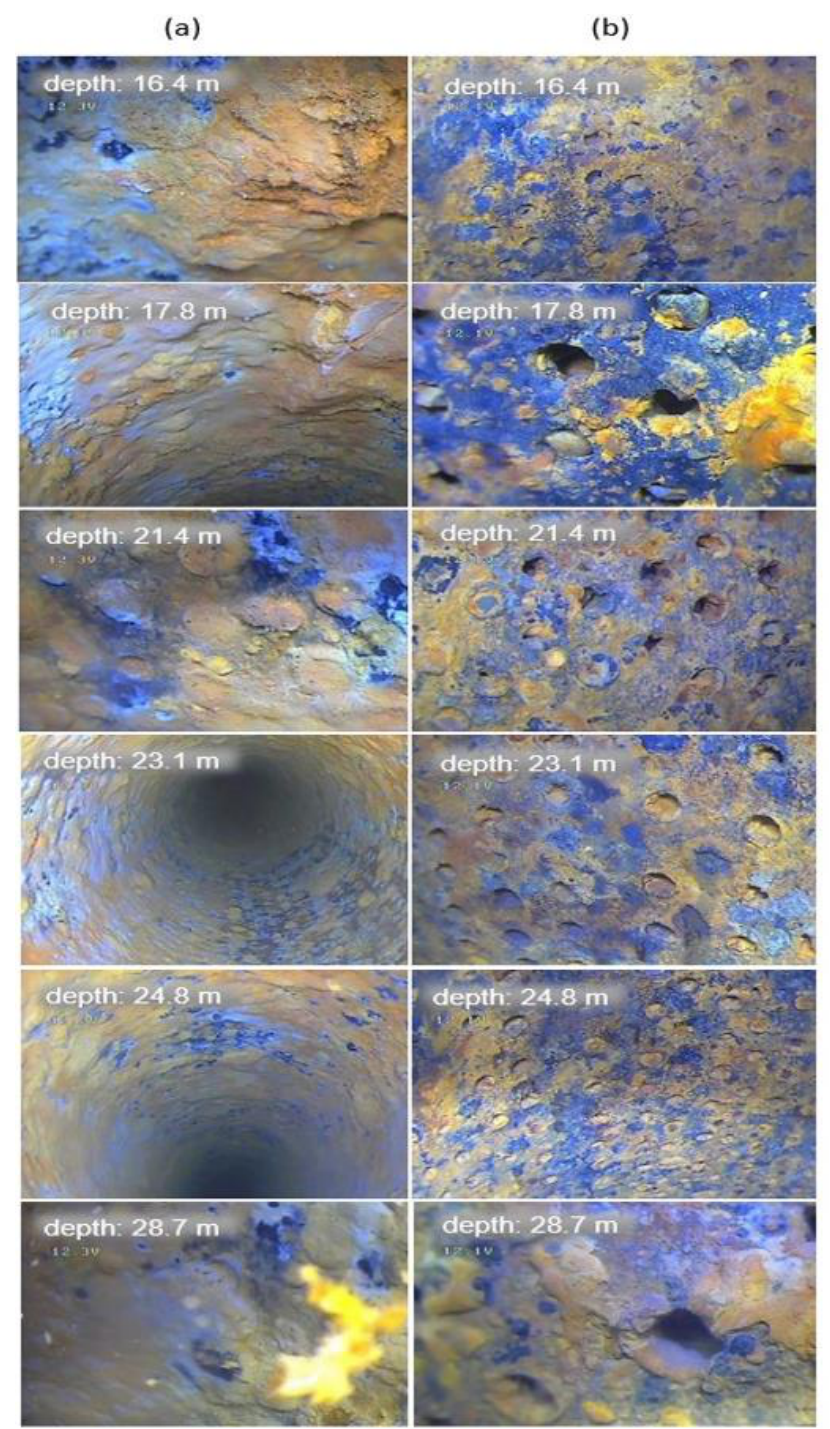
Figure 8. Example of a camera inspection of the interior of well MO-4 at different depths before ( a ) and after ( b ) rehabilitation. and after ( b )